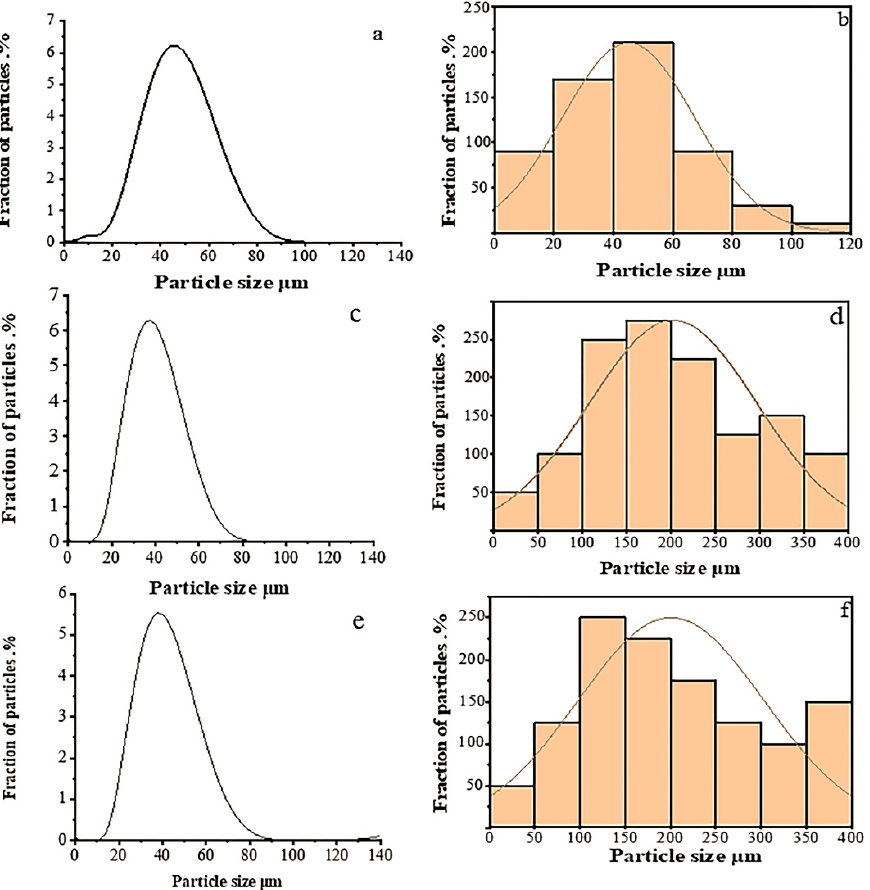
Figure 2. Particle size distribution using laser particle size analyzer for AG ( a , b ); NG ( c , d ) and EG ( e , f ).